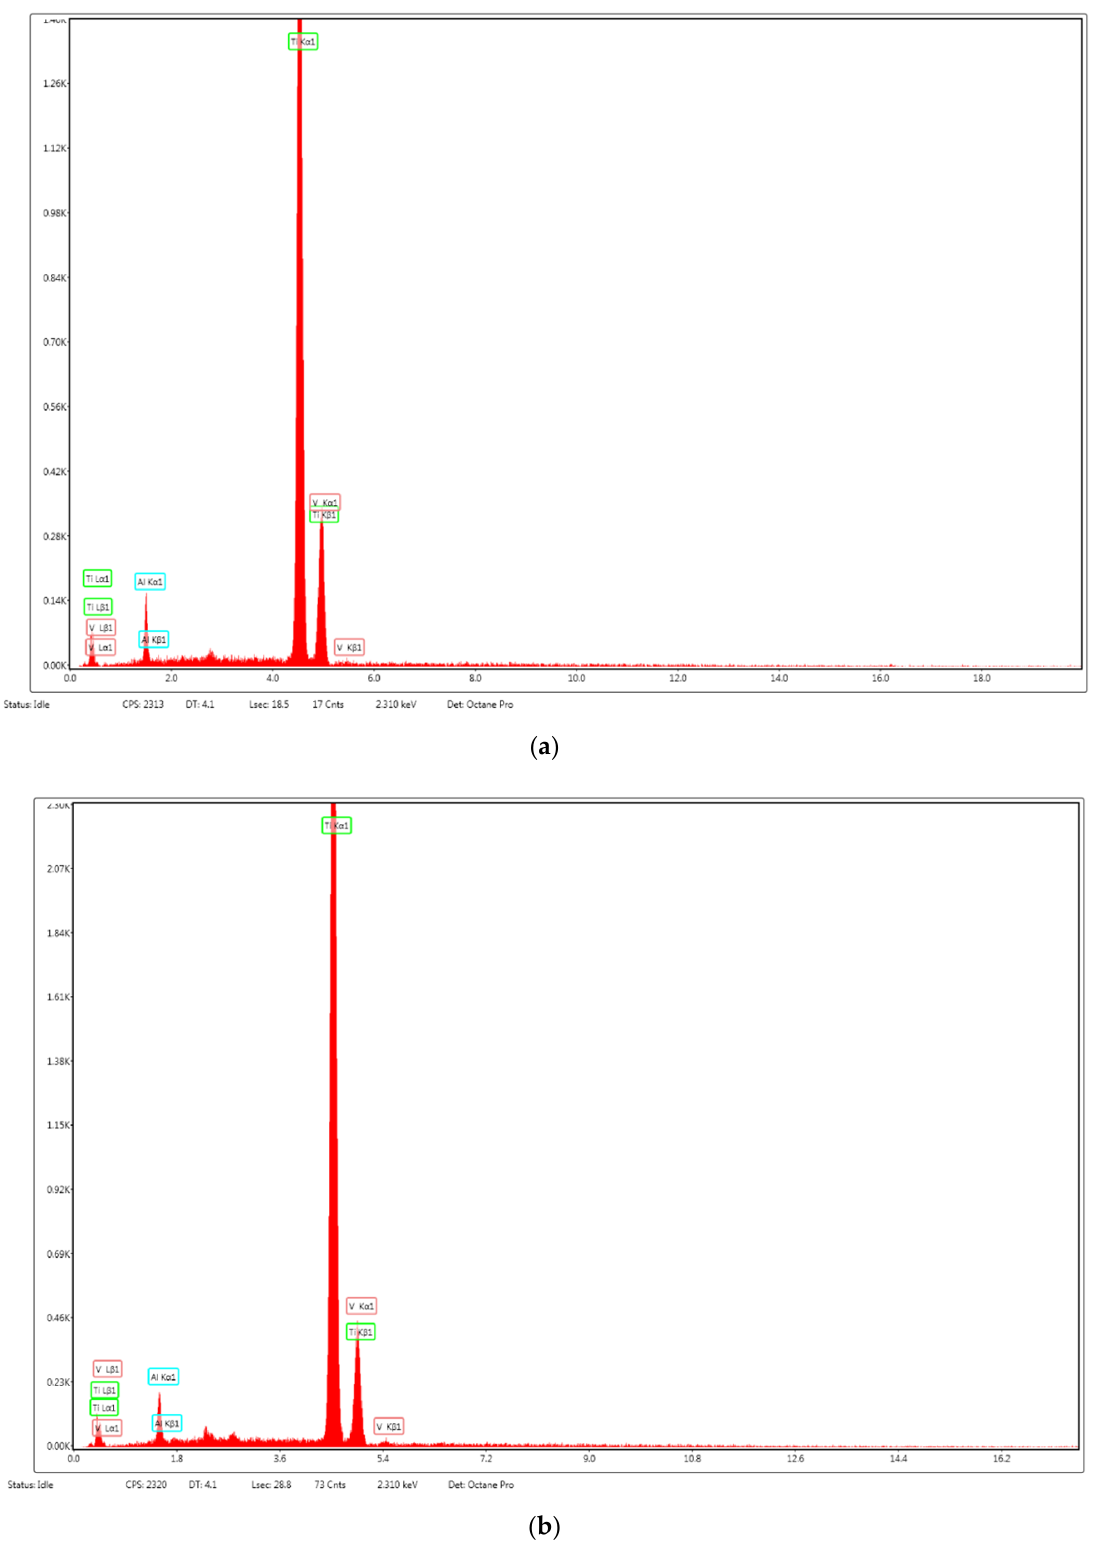
Figure 6. EDS analysis of sintered samples of Ti6Al4V alloy fabricated using DMLS process: ( a ) sintered samples; ( b ) weld deposit zone.